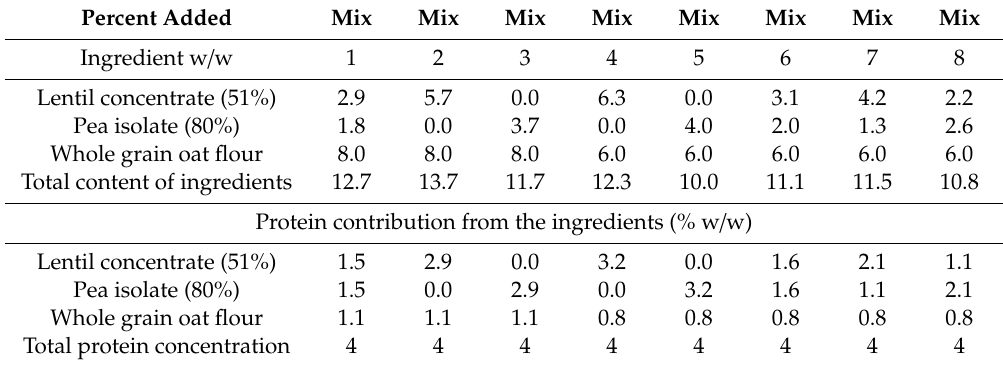
Table 1. Added ingredients and their protein contributions to the mixed PBDs.